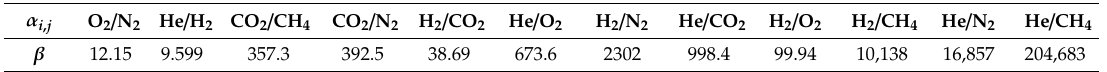
Table 2. Values of the y-intercept of the Robeson upper bound ( β = k − 1/ n ) for the di ff erent gas pair separations. α / N / H / CH / N / CO / O i , j O 2 2 He 2 CO 2 4 CO 2 2 H 2 2 He